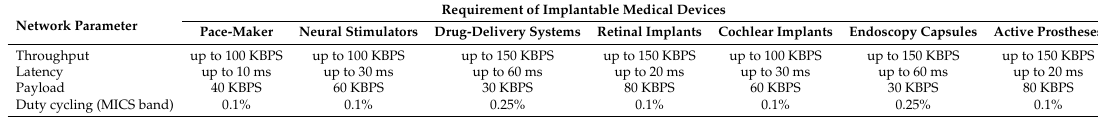
Table 4. Requirements of wireless communication in implantable medical